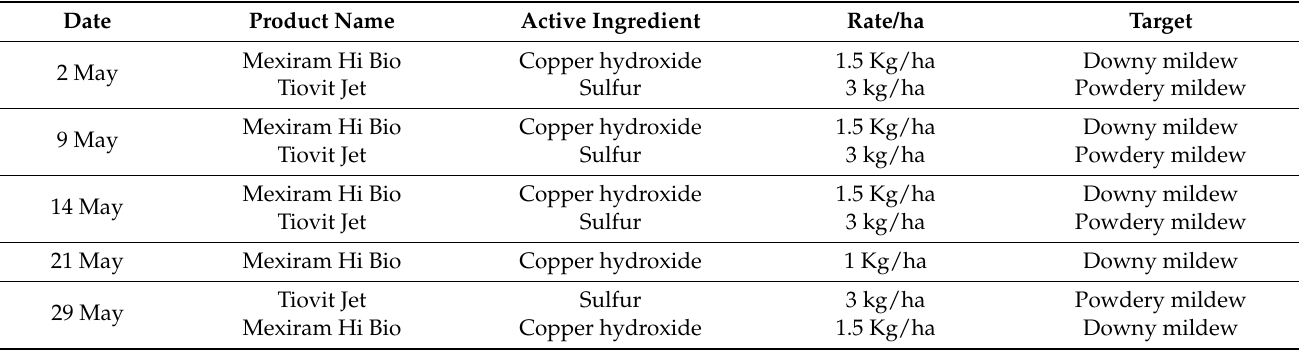
Table 3. Dates, product names, rates, active ingredients, and the target of plant health treatments realized in the Soave vineyard during